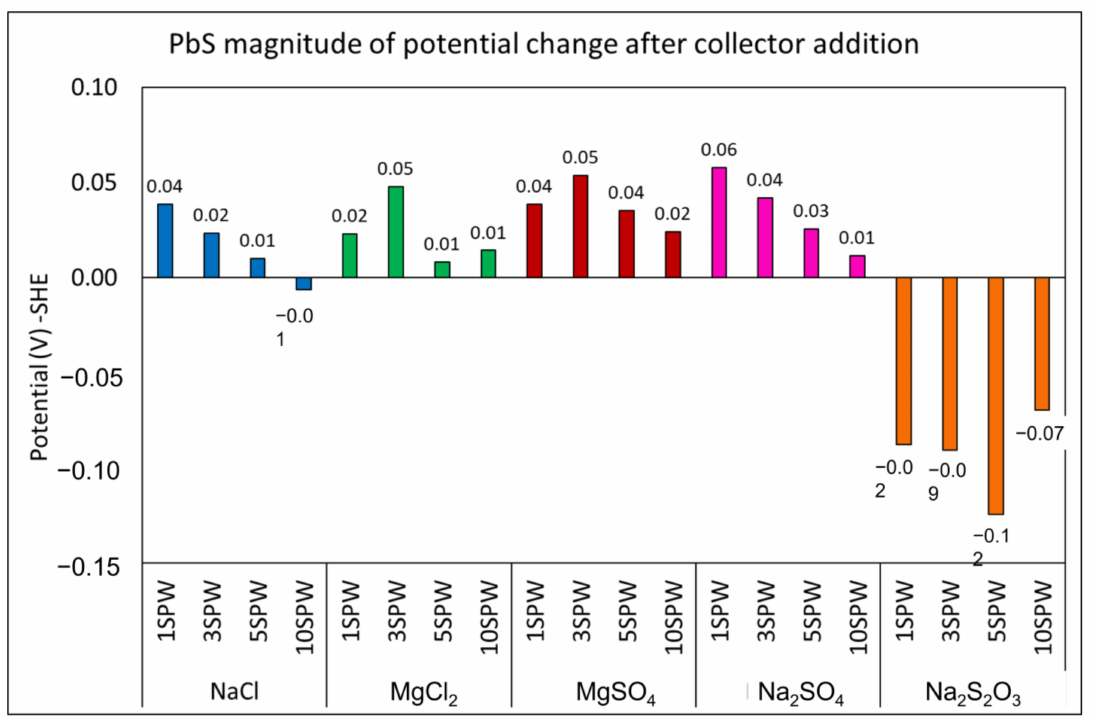
Figure 2. Extent of potential change after SEX addition for galena with changing water